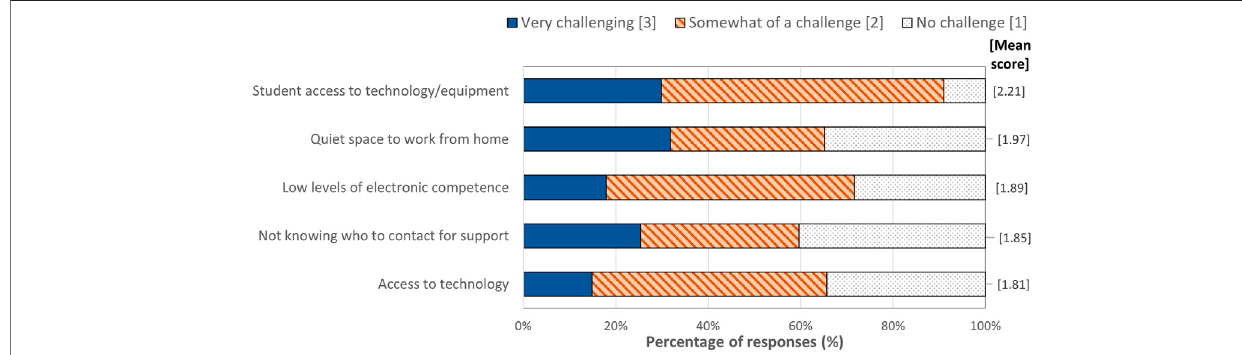
FIGURE 1 | Challenges in IT resources and support when transitioning to online teaching.